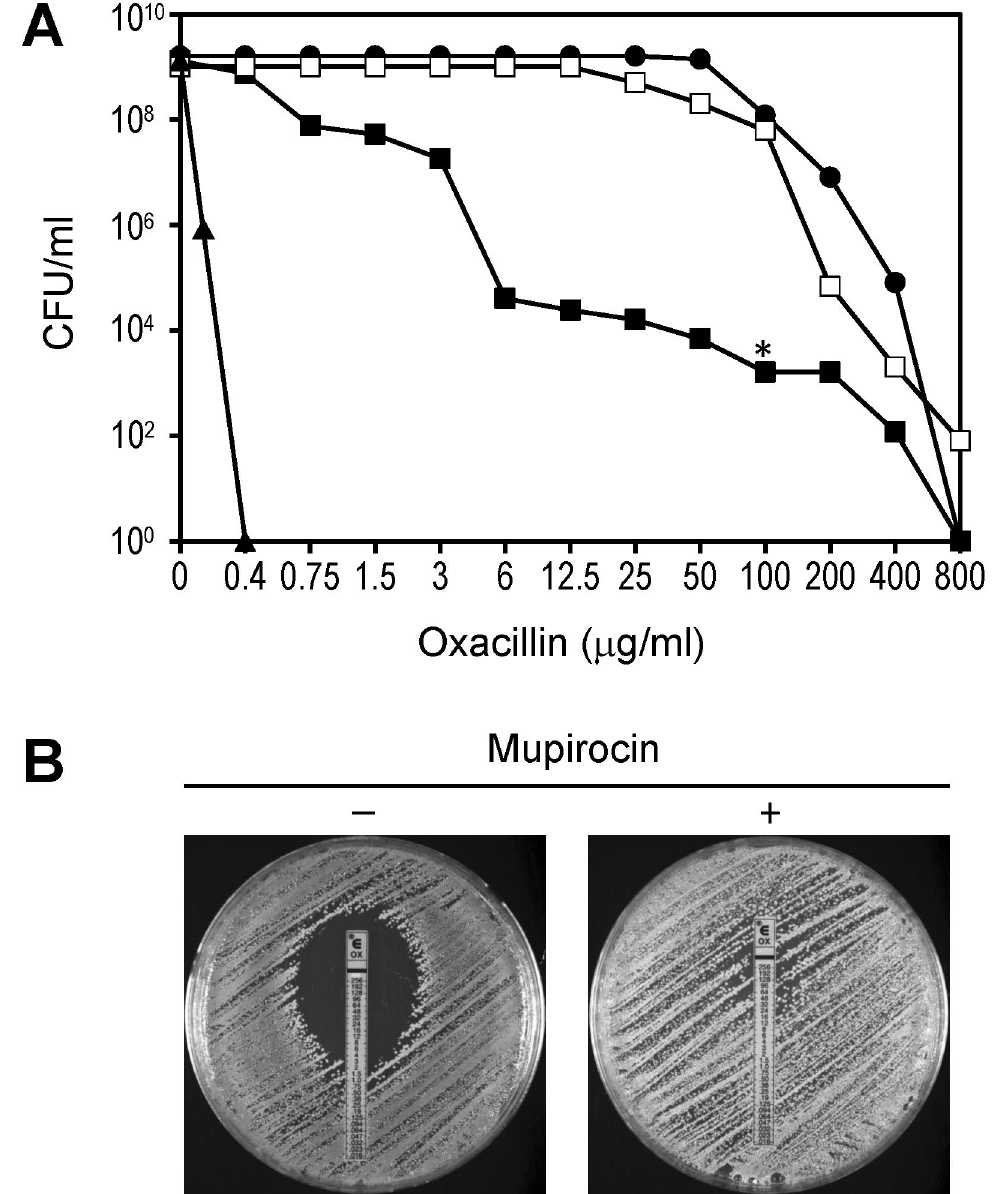
Figure 2. Heterogeneous expression of oxacillin resistance in the laboratory strain RUSA11. (A) Oxacillin resistance level of the strains was determined by population analysis profiles (PAPs). PAP of the susceptible S. aureus recipient strain RN2677 (▲), oxacillin resistant strain RUSA11 (■); RUSA11 tested on oxacillin containing plates supplemented with sub-MIC concentration of mupirocin (□); culture of a highly resistant colony of RUSA11 (*) picked from a plate containing 100 µg/ml oxacillin (●). (B) Oxacillin susceptibility of RUSA11 determined by the E-test on agar plates with or without supplementation of the agar by mupirocin (0.03